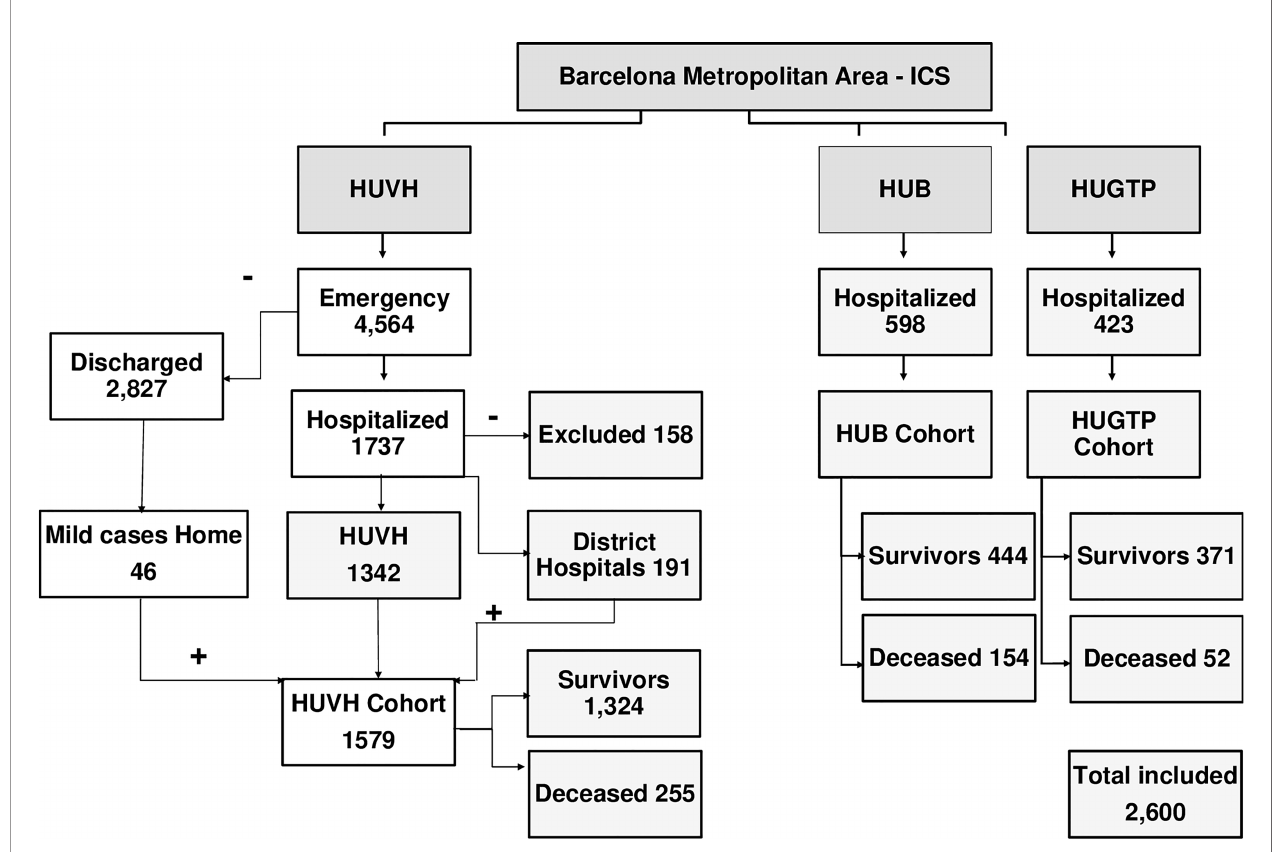
FIGURE 1 | Selection of patients for the cohorts from Vall d ’ Hebron University Hospital (HUVH), Bellvitge University Hospital (HUB), and Germans Trias i Pujol University Hospital (HUGTP). All patients were con fi rmed by polymerase chain reaction (PCR) to have coronavirus disease (COVID-19). The details of the excluded patients are provided in Table S1 . The data from HUVH corresponds to patients who were admitted to the emergency division between 10 March and 29 April 2020; to HUGTP between 17 March and 12 May 2020; and to HUB between 16 March and 23 September 2020. The number of deceased patients corresponds to the 28-day follow-up period. The HUB and HUGTP cohorts include only hospitalised patients but in the HUVH cohort, 46 patients were discharged home or to a medicalized hotel within 24h and monitored by the primary care